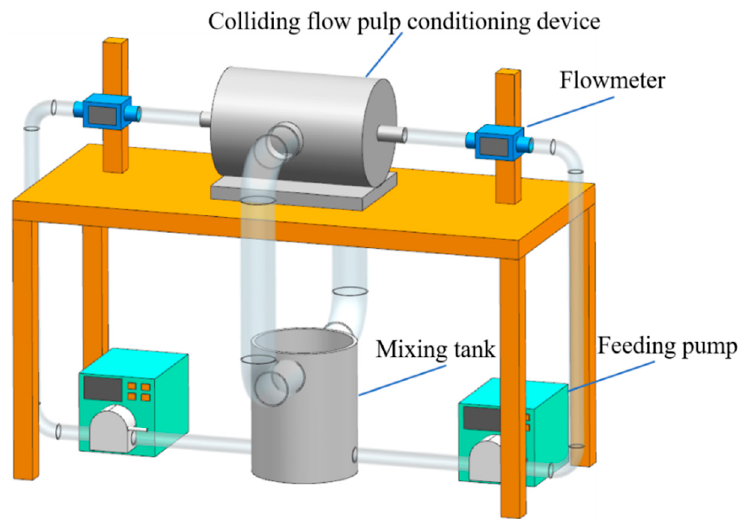
Figure 10. The schematic layout of the pulp conditioning experimental setup.